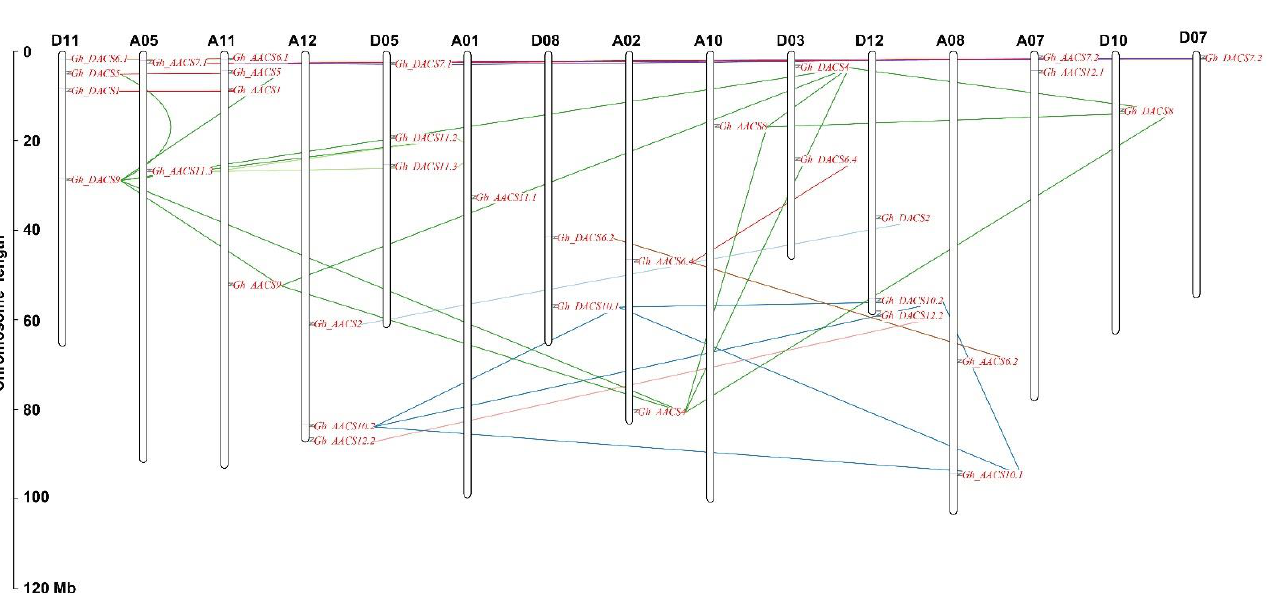
Figure 4. Conserved motifs in the GhACS proteins and exon – intron structure of the GhACS genes.